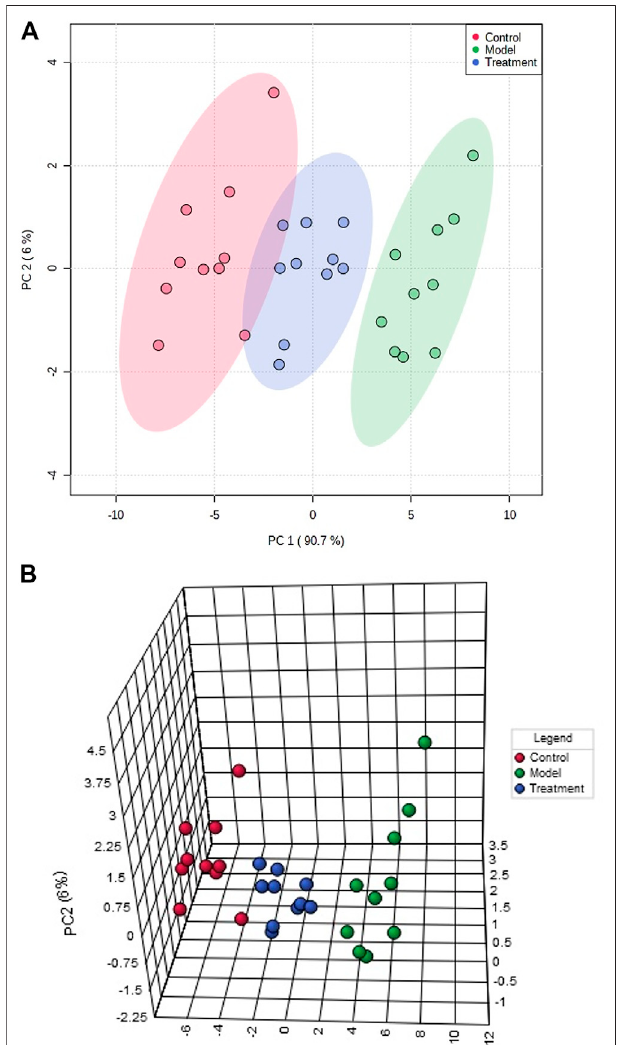
FIGURE 3 | The score plot of control group, model group and treatment groups in the PCA model using metabolomics method based on liquid chromatography coupled with mass spectrometry (A) . PCA 3-D score plot of control group, model group and treatment groups in the PCA model using metabolomics method based on liquid chromatography coupled with mass spectrometry (B)